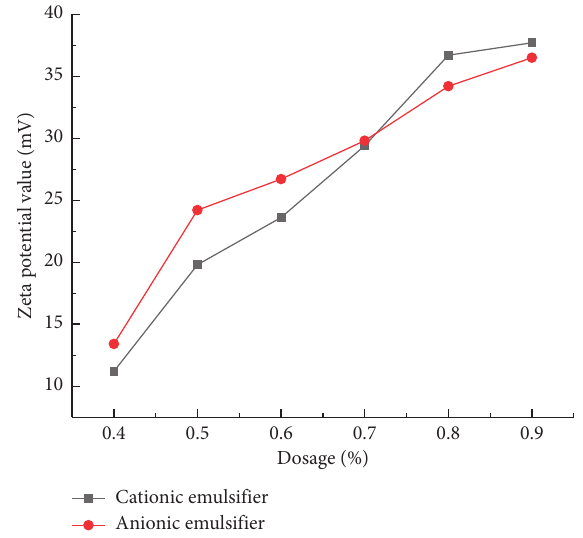
Figure 4: The effect of stabilizer dosage on the zeta potential